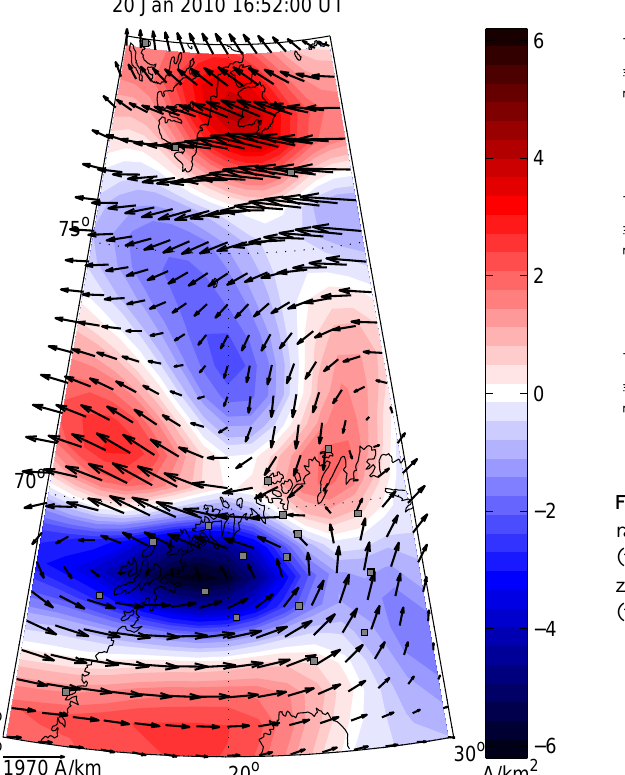
Fig. 7. Horizontal distribution of equivalent currents (black vectors) from the IMAGE magnetometer data during substorm 2. The blue and red colours indicate FAC density up and down, respectively, estimated as the vorticity of the horizontal currents. The strongest currents occurred in the onset region at 16:52UT.